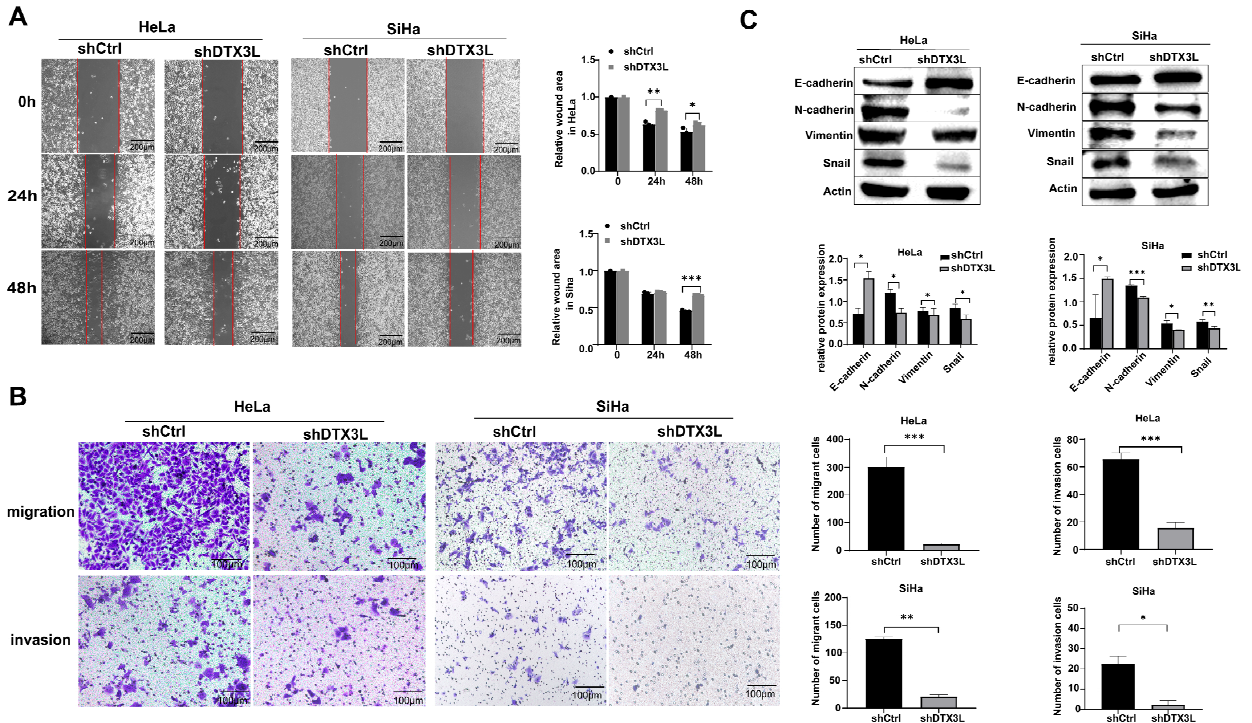
Figure 4. Silencing DTX3L inhibited the migration and invasion of CC cells. ( A ) HeLa and SiHa cells transfected with shDTX3L or shCtrl were photographed 0 h, 24 h and 48 h after scratching the cell surface. Quantification of wound areas were showed in the right panel. ( B ) HeLa and SiHa cell migration and invasion were tested by Transwell assays (crystal violet stain, magnification: 20 × ). The quantified result is shown in the right panel. ( C ) Expression of EMT ‐ related proteins (E ‐ cadherin, N ‐ cadherin, Snail and Vimentin) in HeLa and SiHa cells transfected with shDTX3L or shCtrl was analyzed using Western Blot analysis. The bar chart in the right shows the ratio of E ‐ cadherin, N ‐ cadherin, Snail and Vimentin to Actin according to densitometry. * p < 0.05, ** p < 0.01, *** p < 0.001.